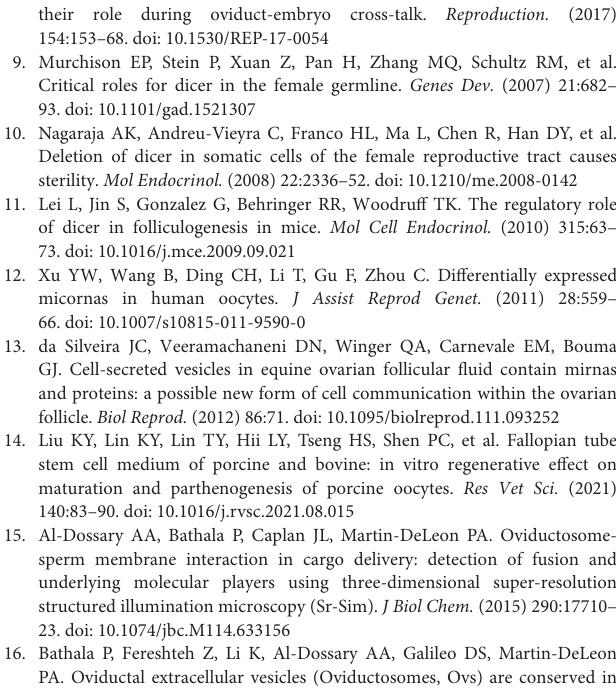
Supplementary Table 1 | The list of 267 miRNAs identified by next generation sequencing. Supplementary Table 2 | The list of targeted genes affecting MAPK